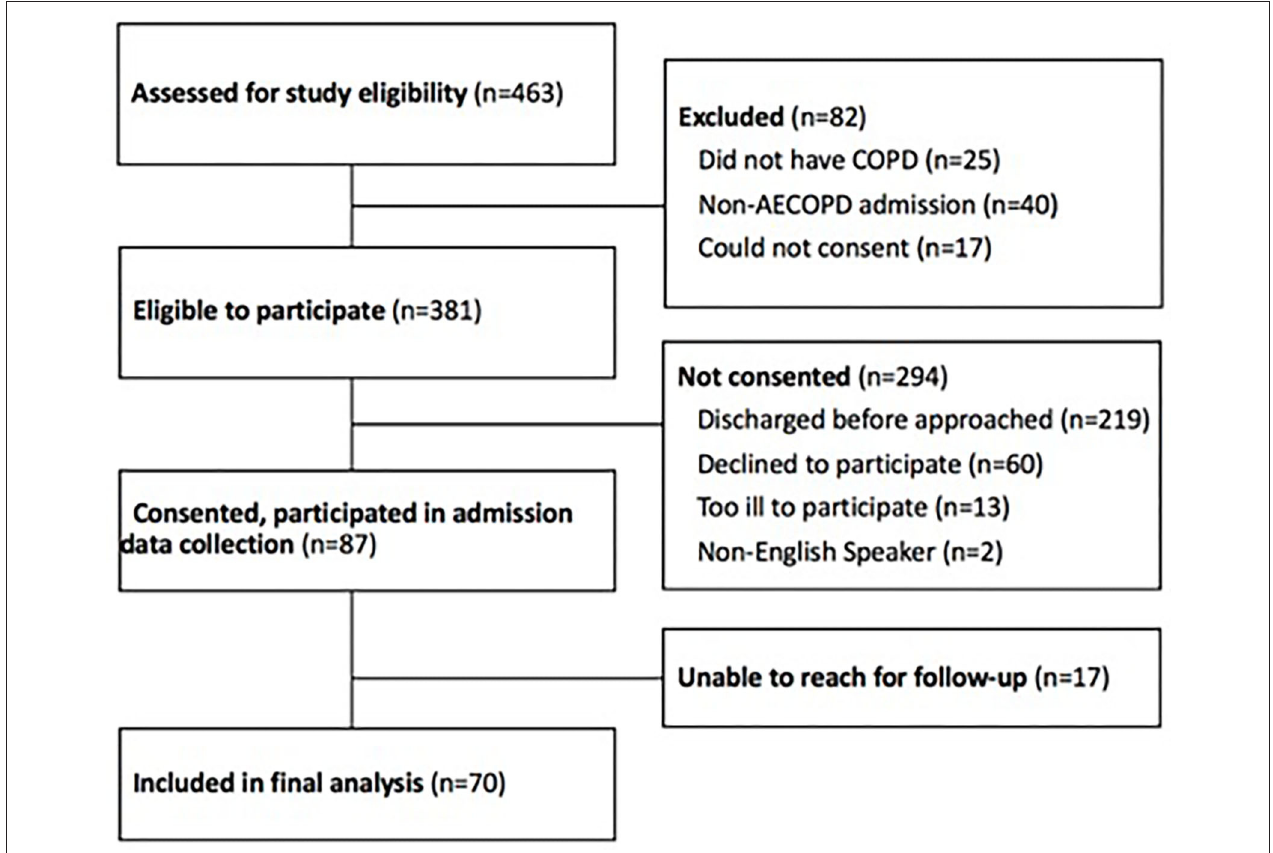
FIGURE 1 | Study participants. COPD, chronic obstructive lung disease; AECOPD, acute exacerbation of chronic obstructive lung